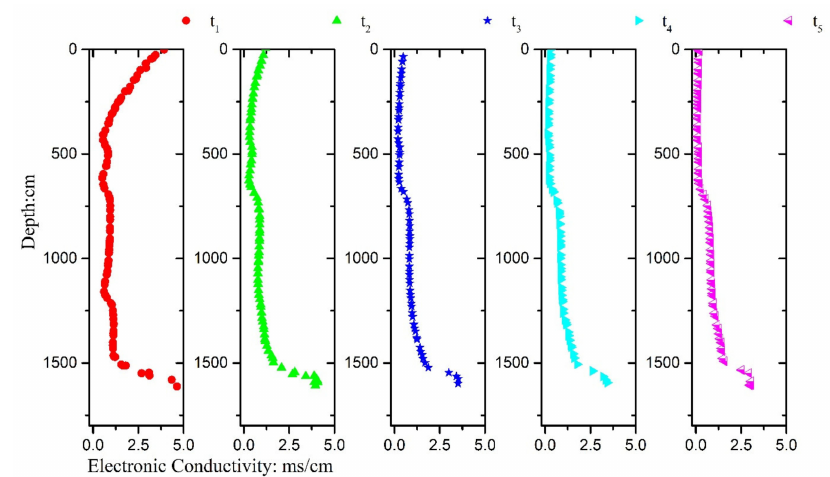
Figure 9. EC profiles of P9-12 at different times.